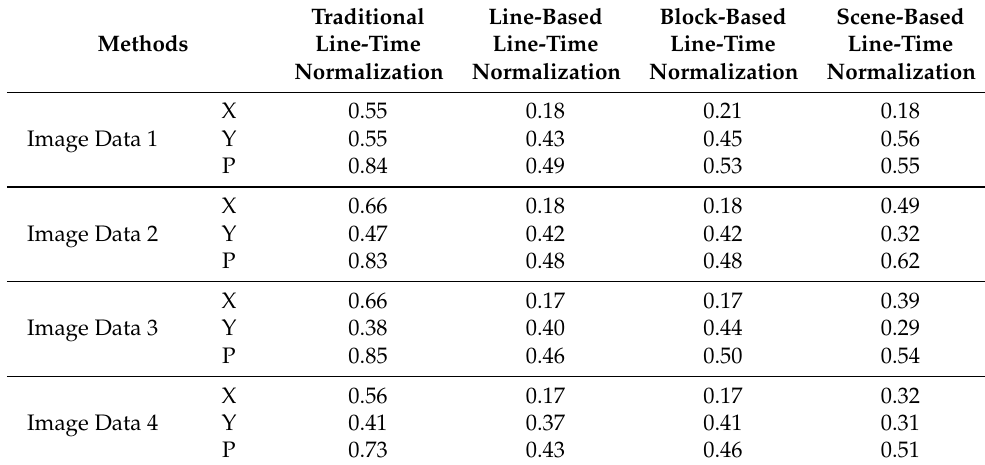
Table 3. Stitching error between adjacent sub-CCD images (pixels).